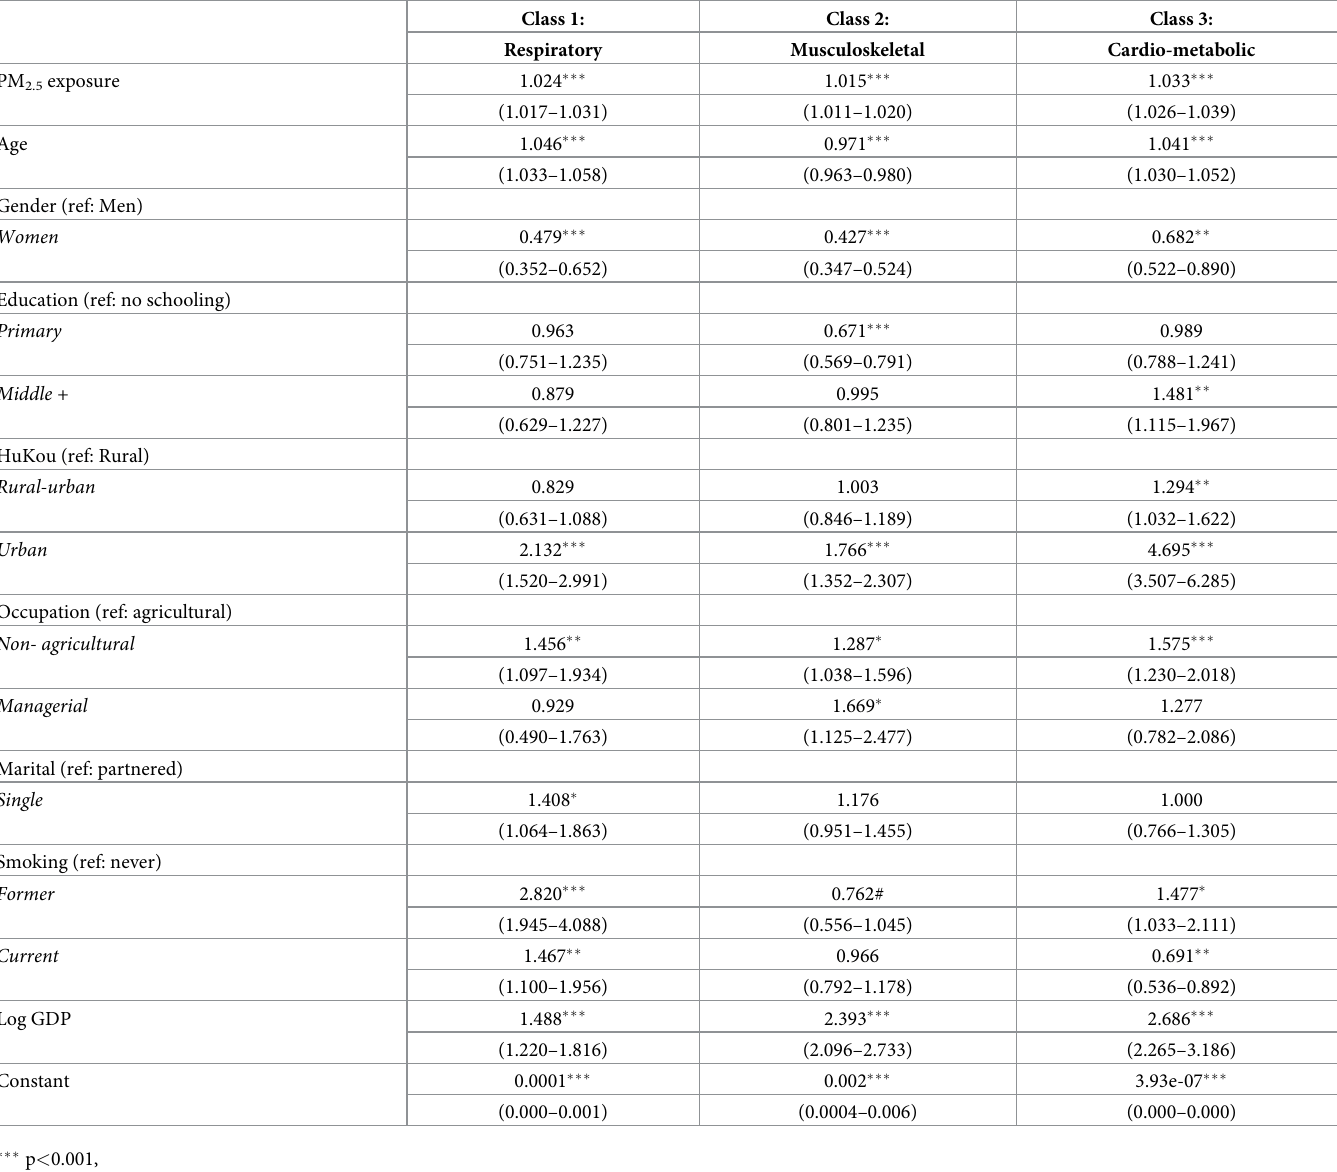
Table 3. Odds ratios with 95% confidence intervals from multinomial logistic regression results for PM 2.5 by latent disease class (reference class: Relatively healthy), CHARLS